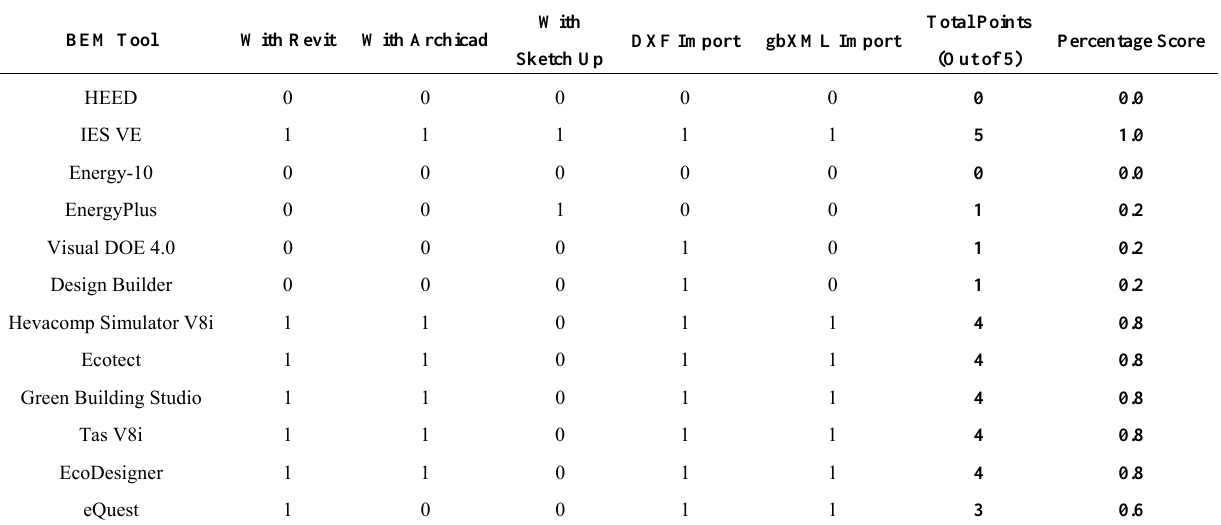
Table A1. Initial evaluation: interoperability criterion calculations for BEM